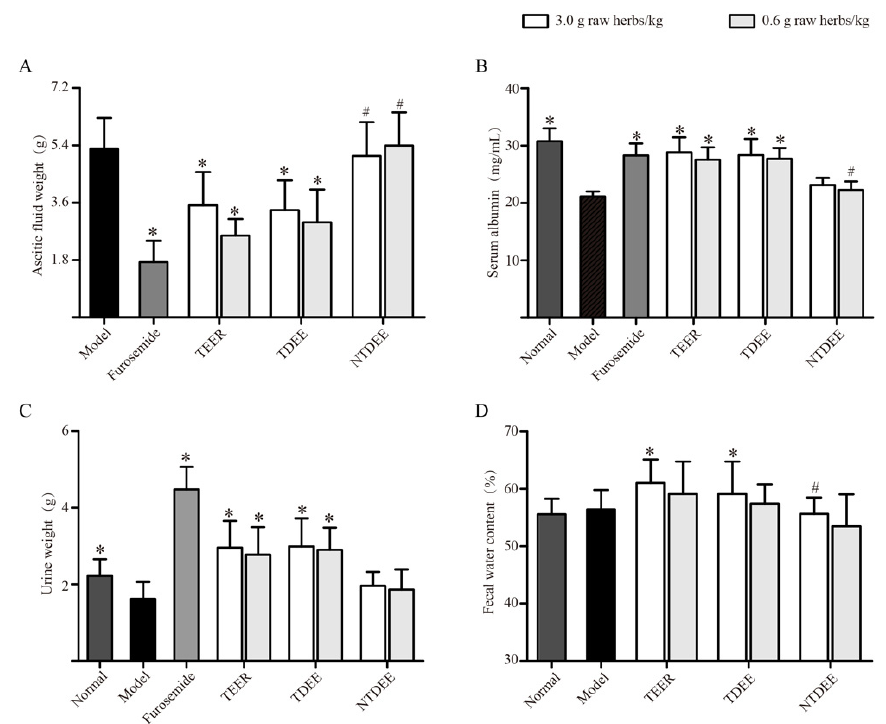
Figure 1. Effects of extracts from the root of Euphorbia ebracteolata Hayata (EER) on ascitic fluid weight ( A ), serum albumin levels ( B ), urine weight ( C ), and fecal water content ( D ) in H22 tumor cell-bearing mice. Normal: normal mice treated with blank solvent. Model: H22 tumor cell-bearing mice treated with blank solvent. TEER: total extract of EER; TDEE: total diterpenoids from EER; NTDEE: non-diterpenoid fraction of EER. The data are represented as mean ± SD, n = 10, * p < 0.05 vs. model group (one-way ANOVA followed by Dunnett test); # p < 0.05 vs. TEER group using the same dose (one-way ANOVA followed by Dunnett test).